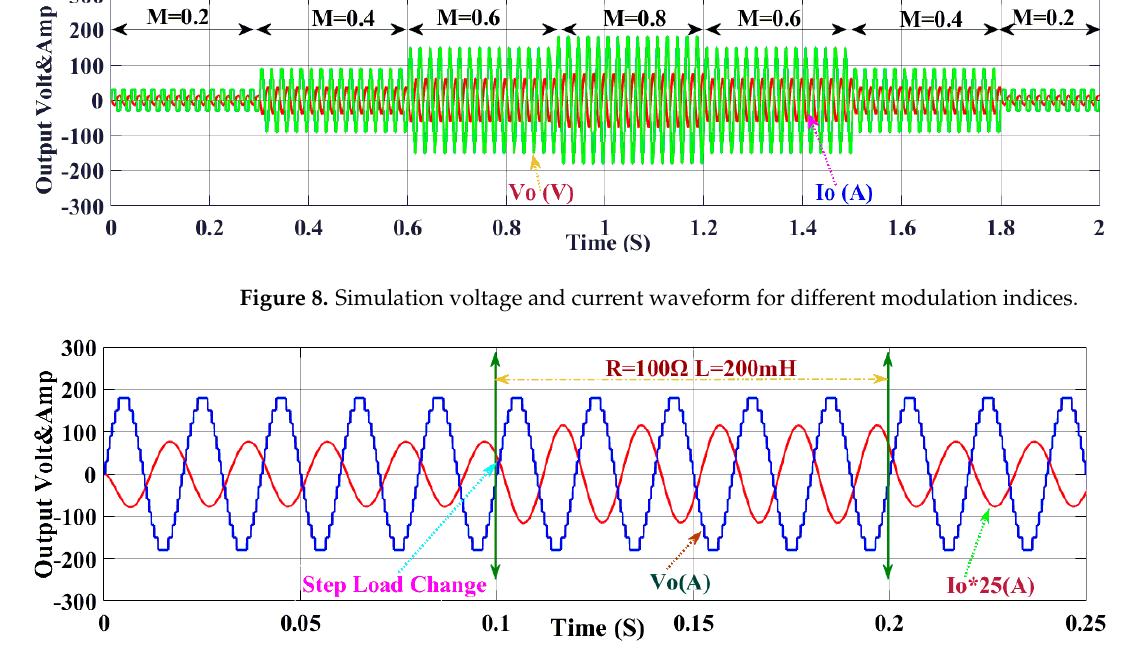
Figure 9. Simulation response of voltage and current waveform with step load change.